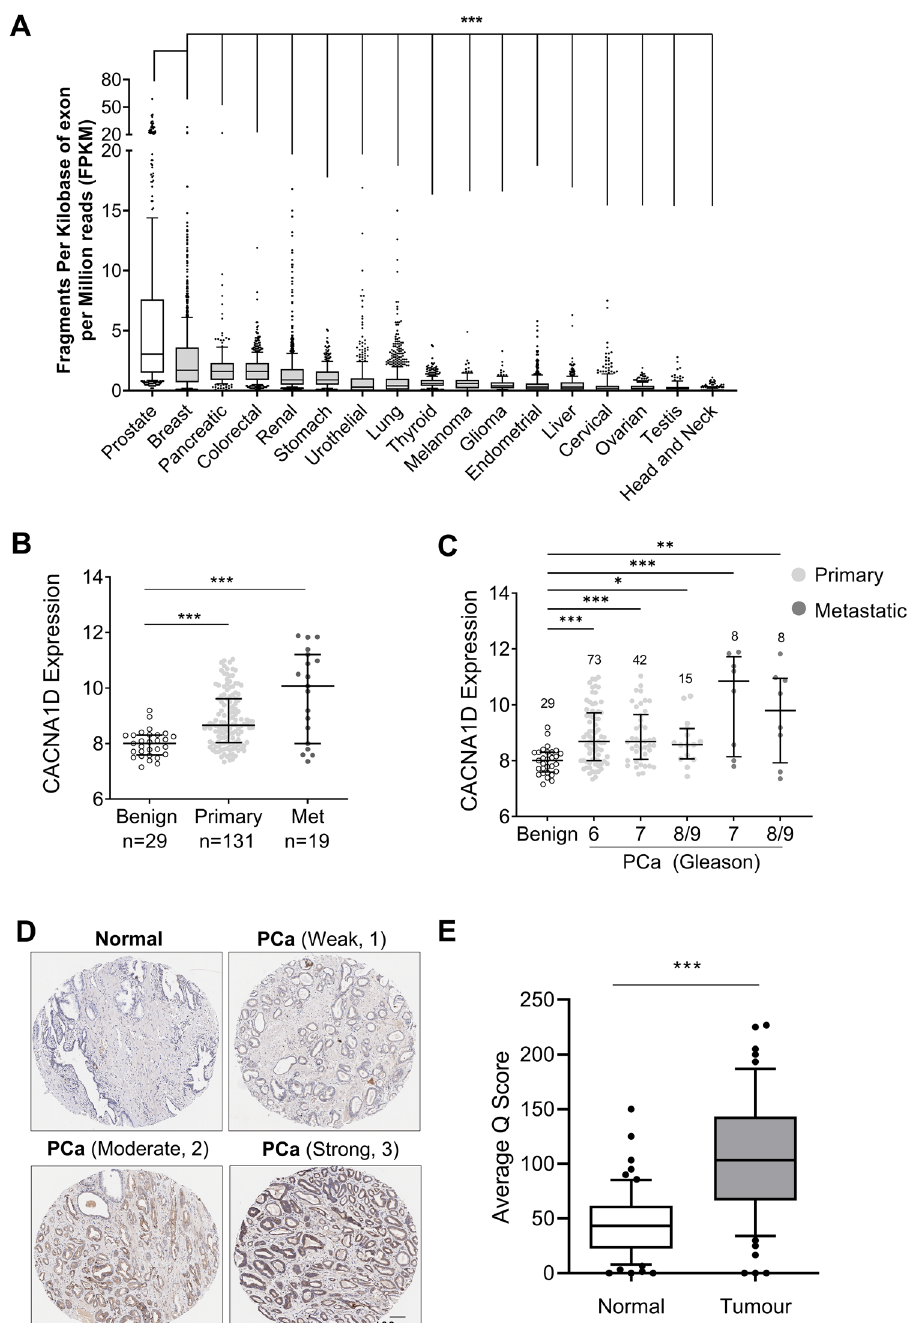
Figure 1. Profiling CACNA1D and Ca V 1.3 expression in clinical PCa datasets and tissue microarrays. ( A ) Human CACNA1D transcript expression was determined by RNA-seq analysis from 7932 TCGA samples from 17 different cancer tissues. Data was obtained from The Human Protein Atlas (www. prote inatl as. org/) ENSG00000157388-CACNA1D/pathology (v21.1.proteinatlas.org), is presented as box-and-whisker plots (median, 10–90 percentile) and was analysed with Kruskal– Wallis, Dunn’s multiple comparison test p < 0.001 (***). ( B ) Scatter plot showing CACNA1D expression in primary (n = 131) PCa and metastatic PCa (n = 19) compared to adjacent benign prostate tissue (n = 29). Data was derived from GEO dataset, GSE21032 (GPL 5188) conducted by Memorial Sloan-Kettering Cancer Centre (MSKCC). Data is expressed as median and inter-quartile range and was analysed using Kruskal–Wallis, Dunn’s multiple comparison test, p < 0.001 (***). C . CACNA1D expression was compared by Gleason grade (6, 7 and 8–9) between primary and metastatic PCa samples. Data was derived from GEO dataset, GSE21032 (GPL 5188, MSKCC) and analysed using Kruskal–Wallis, Dunn’s multiple comparison test. Data is expressed as median and inter-quartile range where significance is indicated as p < 0.05 (*), p < 0.01 (**) and p < 0.001 (***). D. E xamples of normal/benign and prostate tumour tissue cores from an in house tumour PCa microarray, stained with anti-Ca V 1.3 (HPA020215, Sigma Aldrich). Tissues were assessed by a Q scoring system. Staining intensity was scored as weak (1), moderate (2) and strong (3) and was multiplied by the percentage of tissue encompassed by the designated staining. ( E ) Q scores (median, 10–90 percentile) showing significant Ca V 1.3 overexpression in tumour vs normal/benign tissues (N = 67, Mann–Whitney, unpaired, p < 0.001